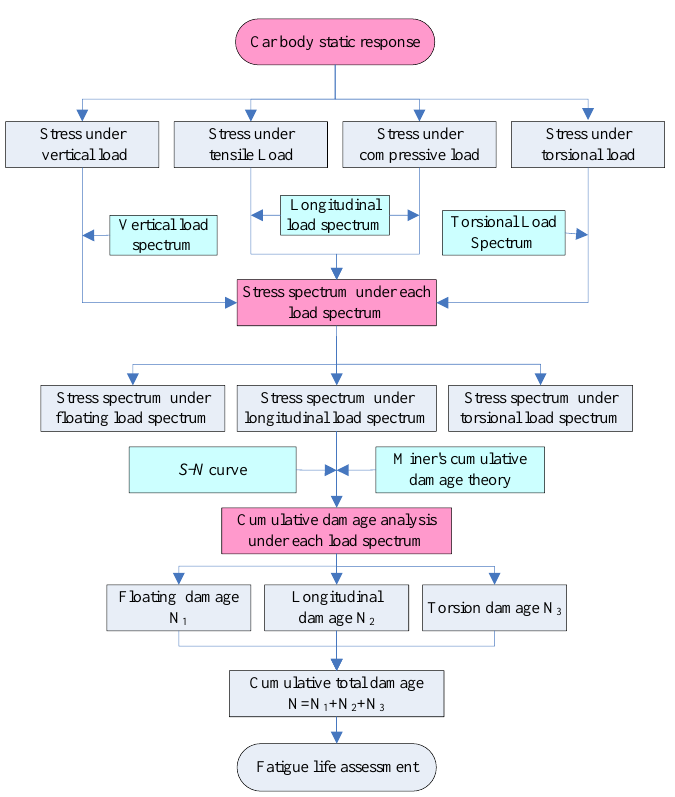
Figure 4. The analysis flow chart of fatigue damage.